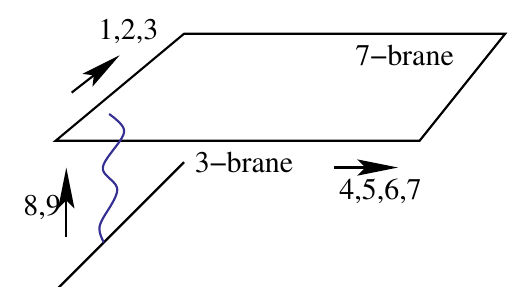
Figure 1. Quarks can be added to N = 4 SYM as 3-7 strings in the D3-D7